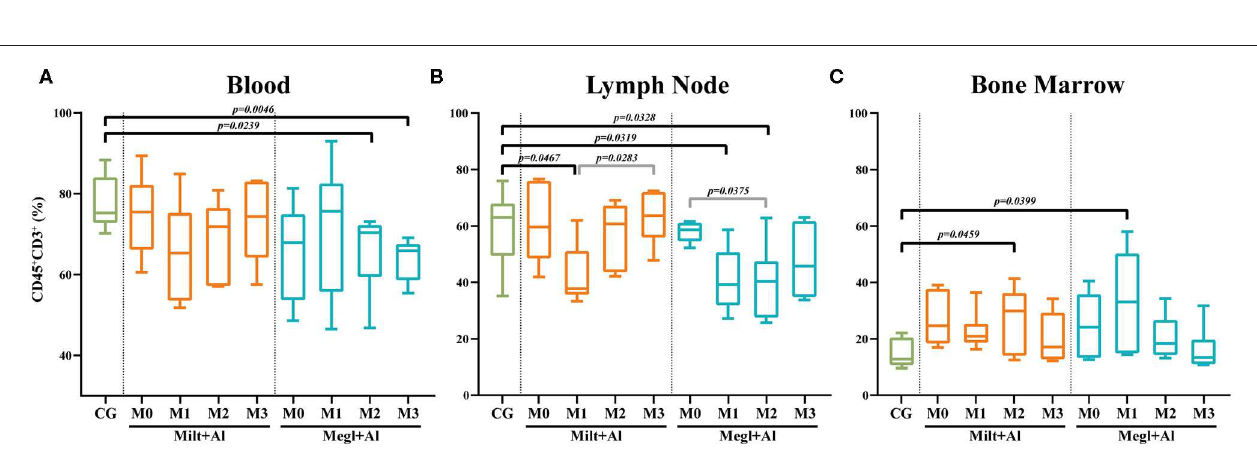
FIGURE 4 | Frequency of lymphocytes (CD45 + CD3 + ) in the blood (A) , lymph node (B) , and bone marrow (C) of healthy [control group (CG)], sick (M0), and treated dogs (M1, M2, and M3). Results of 22 dogs are represented by box and whisker plots and median, minimum, and maximum values. The non-parametric Kruskal–Wallis test (one-way ANOVA on ranks) with Dunn’s post hoc test was used for statistical comparisons between treatment groups and the CG. The repeated measures ANOVA test with Tukey’s post hoc test was used for statistical comparisons inside each treatment group. p -values are indicated in every statistically significant